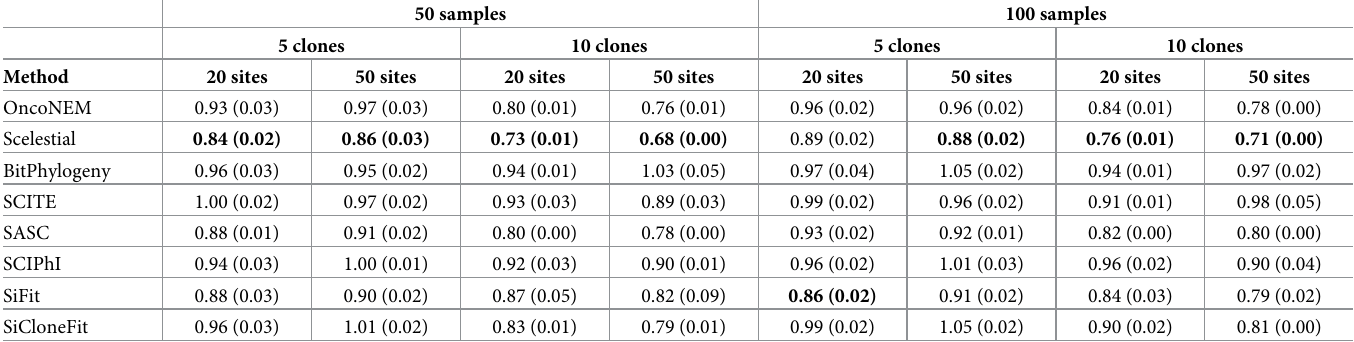
Table 1. Comparison of reconstruction of ground truth lineage tree from data simulated by OncoNEM, showing the distance between the inferred trees and the ground truth for all methods across eight lineage trees. Each cell represents average of tree distance measure for ten different simulated datasets. The best results among all the methods for each evolutionary tree are shown in bold. The variance of the values are represented in brackets. 50